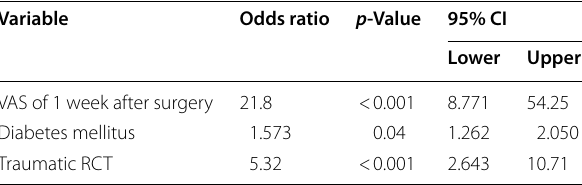
Table 3 Binary logistic regression model showing predictive value of variables for postoperative shoulder stiffness following arthroscopic repair of